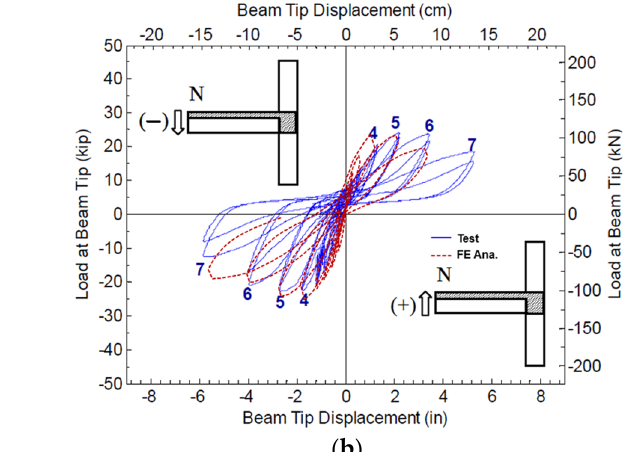
Figure 10. Comparison of crack patterns evaluated in FE analysis with the test observations.